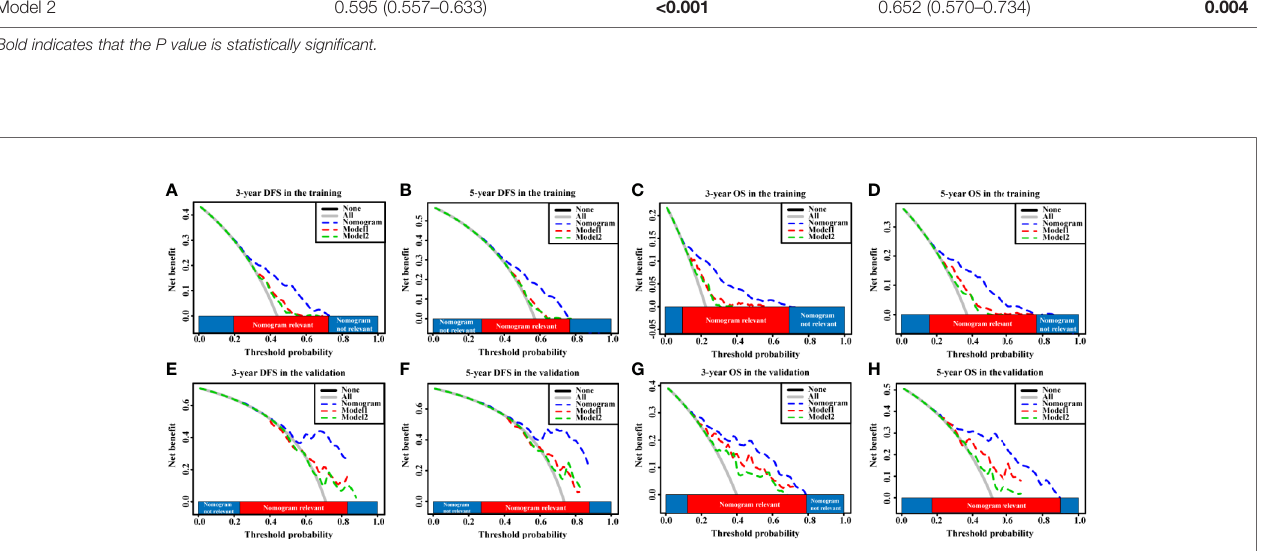
FIGURE 5 | The DCA curves of the nomogram models and other models in HCC patients. (A – D) DCA curves showing the clinical utility of the nomogram models other models for the 3-year DFS (A) and OS (C) rates and 5-year DFS (B) and OS (D) rates in the training cohort. (E – H) DCA curves showing the clinical utility of the nomogram models and other models for the 3-year DFS (E) and OS (G) rates and 5-year DFS (F) and OS (H) rates in the validation cohort. GPR, gamma ‐ glutamyl transpeptidase ‐ to ‐ platelet ratio; ALB, albumin; DCA, decision curves analysis; HCC, hepatocellular carcinoma; DFS, disease-free survival; OS, overall survival.